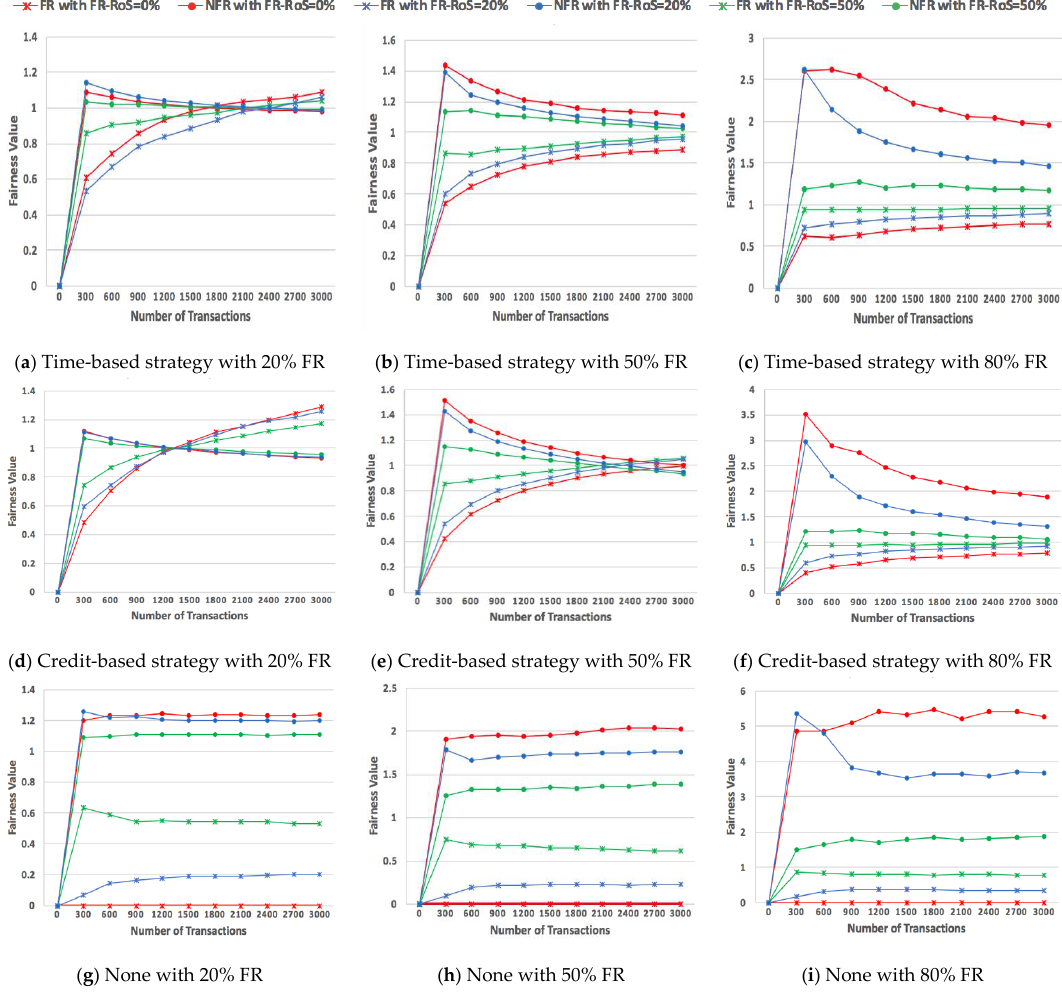
Figure 5. Fairness performance of each strategy.